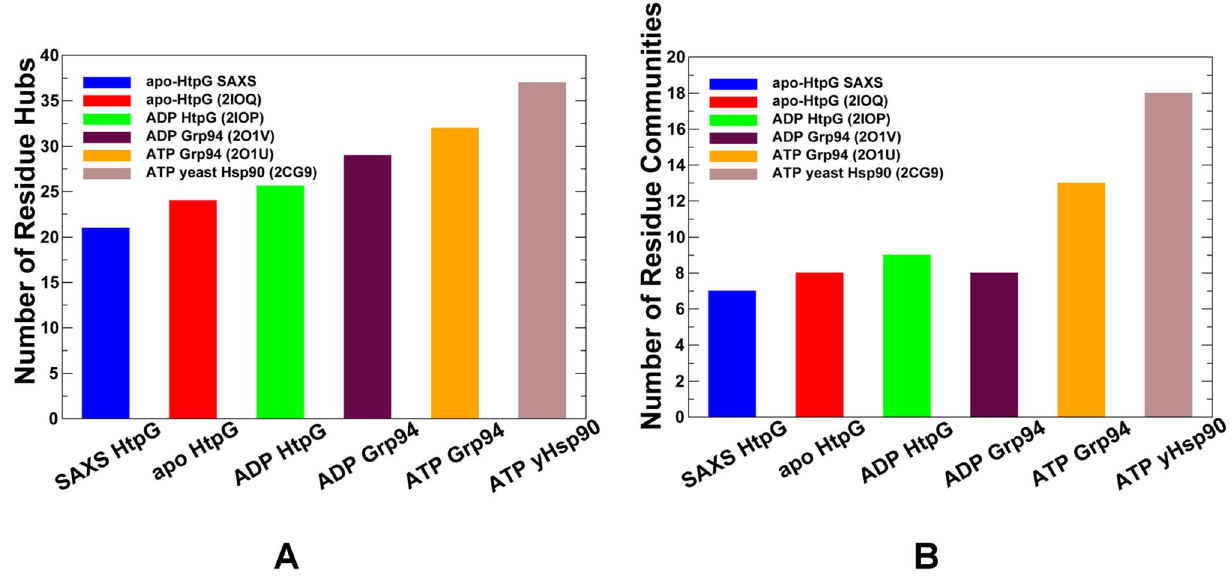
Figure 7. The Network Analysis of the Hsp90 Crystal Structures. The distribution of hubs (A) and communities (B) in different functional states of Hsp90. The distributions of protein structure network parameters are obtained by averaging computations over MD simulation trajectories. The analysis is based on structurally stable residue interaction networks that remained intact in more than 75% of the simulation snapshots. The distributions are shown for the open solution conformation of HtpG obtained from SAXS studies [57,58] (in blue); an apo form of HtpG (PDB ID 2IOQ) [56] (in red); an ADP-bound form of HtpG (PDB ID 2IOP) [56] (in green); an ADP-bound form of the Grp94 homologue (PDB ID 2O1V) [61] (in maroon); an ATP-bound form of the Grp94 homologue (PDB ID 2O1U) [61] (in orange); and an ATP-bound conformation of yeast Hsp90 (PDB ID 2CG9) [55] (in brown).